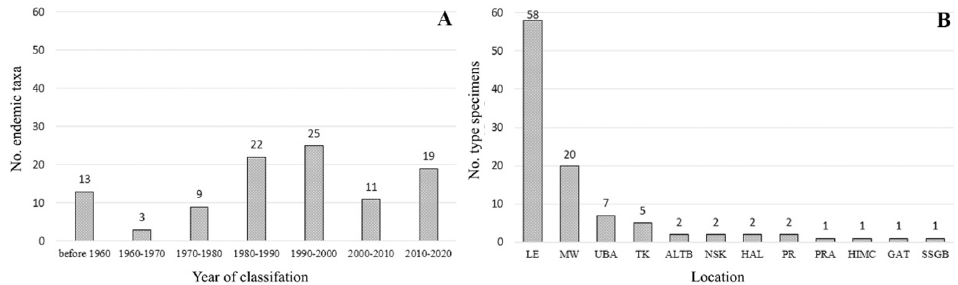
Figure 2. ( A ) Distribution of classification years; ( B ) Distribution of type specimens among herbaria. Only 18 of the 102 taxa have been assessed for IUCN International Conservation Status. However, eight taxa were identified as critically endangered or endangered, and two species were assessed as vulnerable (Appendix A). During our field surveys, endemic taxa were photographed, which were mostly from type localities (Figures A1 and